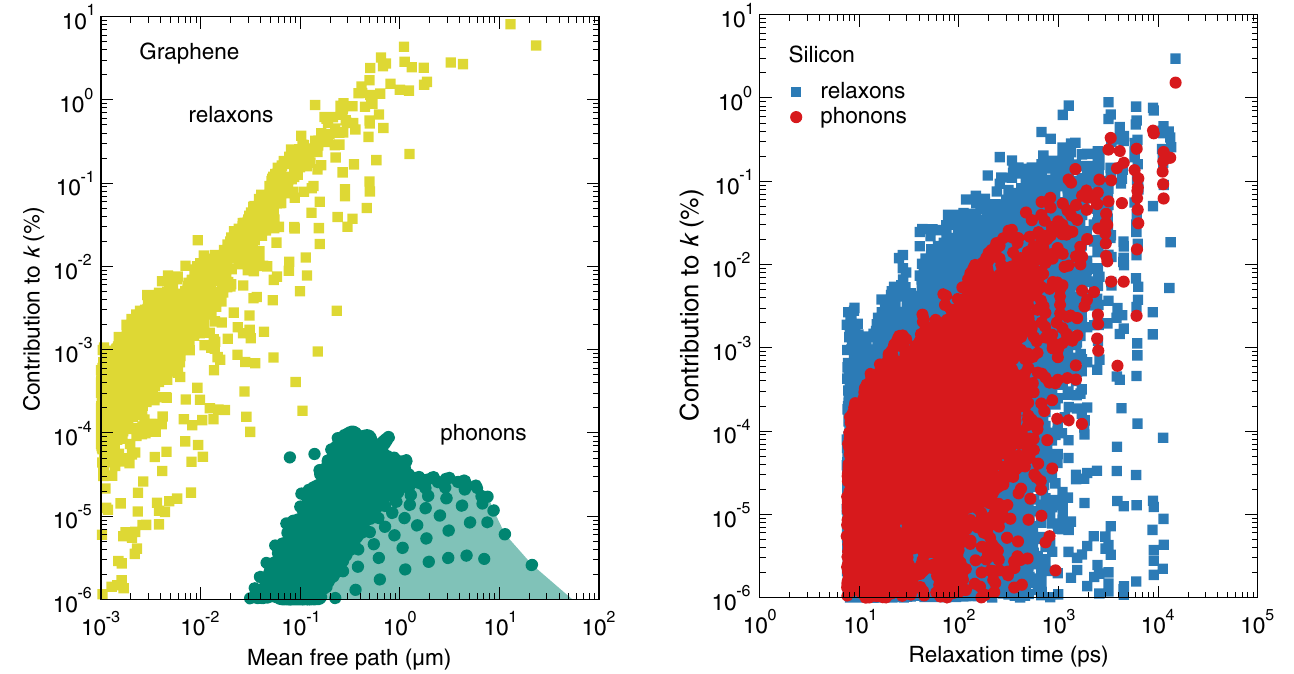
FIG. 5. Analysis of phonon and relaxon mean free paths and their contributions to the thermal conductivity of graphene at room temperature. The spectrum of phonon mean free paths is peaked in the submicron region, whereas relaxon mean free paths are skewed to values larger than 1 μ m. The two largest relaxon mean free paths, illustrating the maximum distance that heat flux can propagate inside the material before decaying, lie between 10 and 100 μ m.